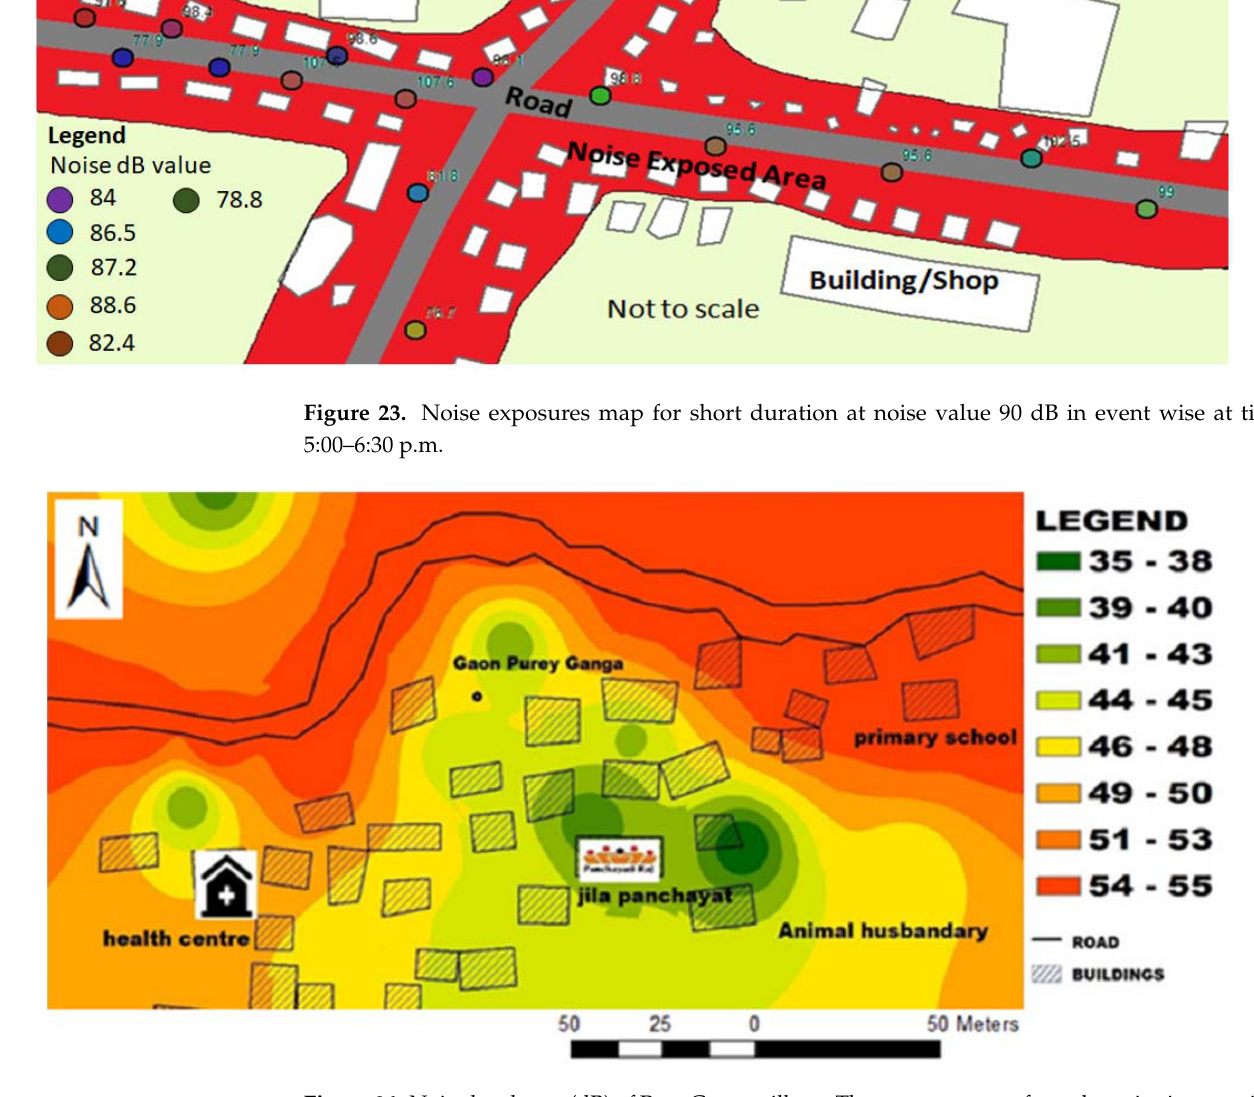
Figure 24. Noise level map (dB) of Pure Ganga village. The area was away from the noisy intersec ‐